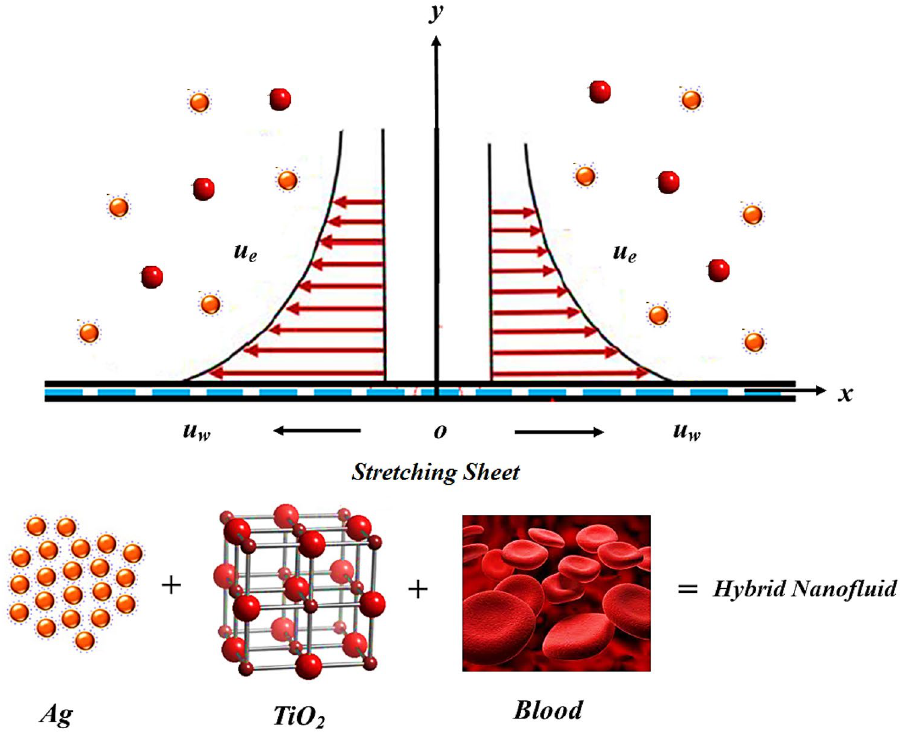
Figure 1. Physical Presentation of the